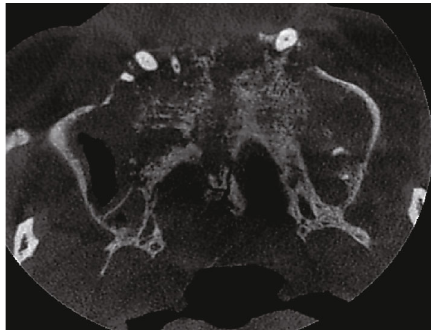
Figure 7: Sagittal section of CBCT revealing destruction of hard palate.